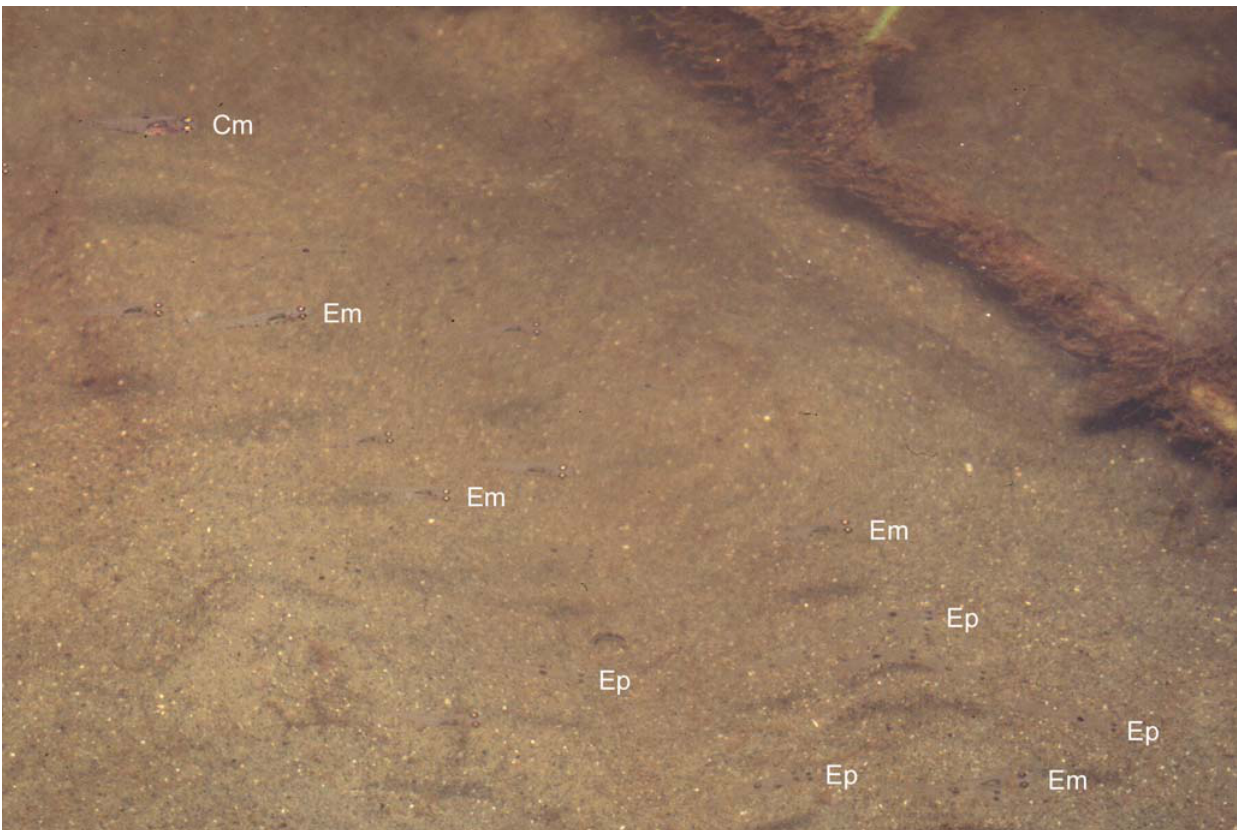
Fig. 3. A mixed column of larval eleotrid fish Eleotris pisonis and gerreid fish Eucinostomus melanopterus , associated with palaemonid shrimps Palaemon pandaliformis , moving upstream in the shallows of a coastal streamlet in Southeastern Brazil. The moving column is closely followed by larger larvae and juveniles of the predaceous centropomid fish Centropomus mexicanus in slightly deeper water. Some individuals marked in front of head to render them easier to spot (Cm= C. mexicanus , Em= E. melanopterus , Ep= E. pisonis ); shrimps not visible against the